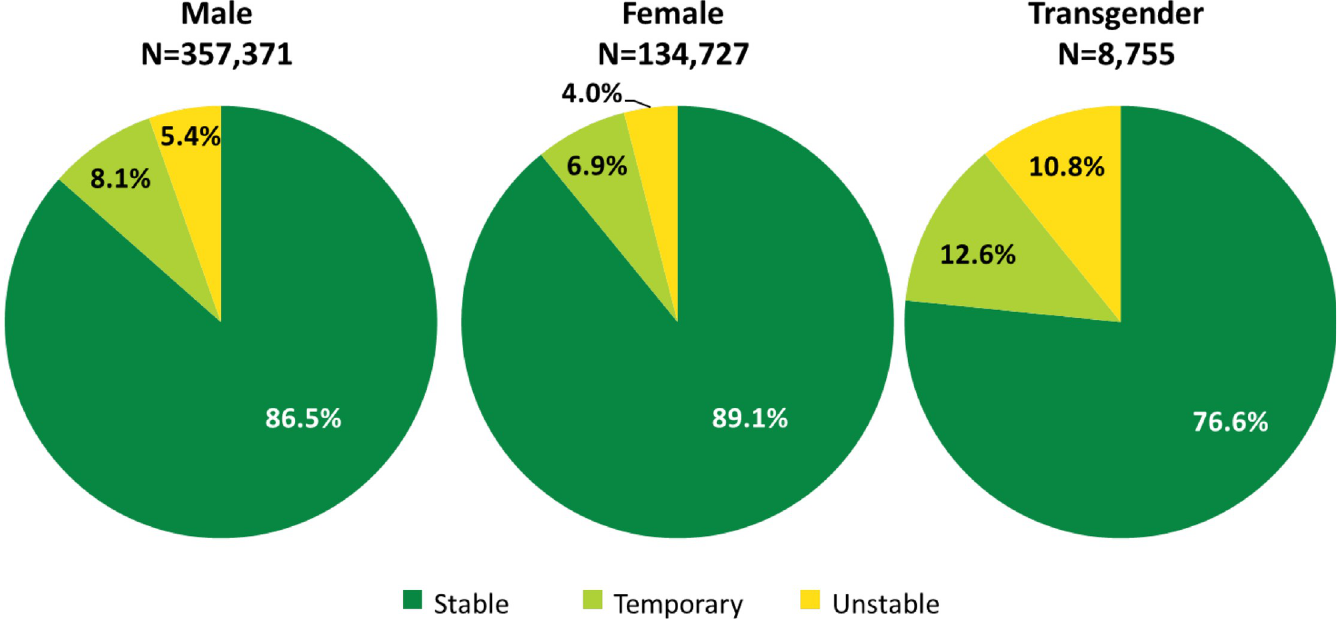
Fig 1. RWHAP clients by gender and housing Status, 2017—US and 3 territories. Source : HRSA . RWHAP Services Report (RSR) 2017 . Does not include AIDS Drug Assistance Program Data. [9] HSRA, Health Resources and Services Administration; RWHAP, Ryan White HIV/AIDS Program.